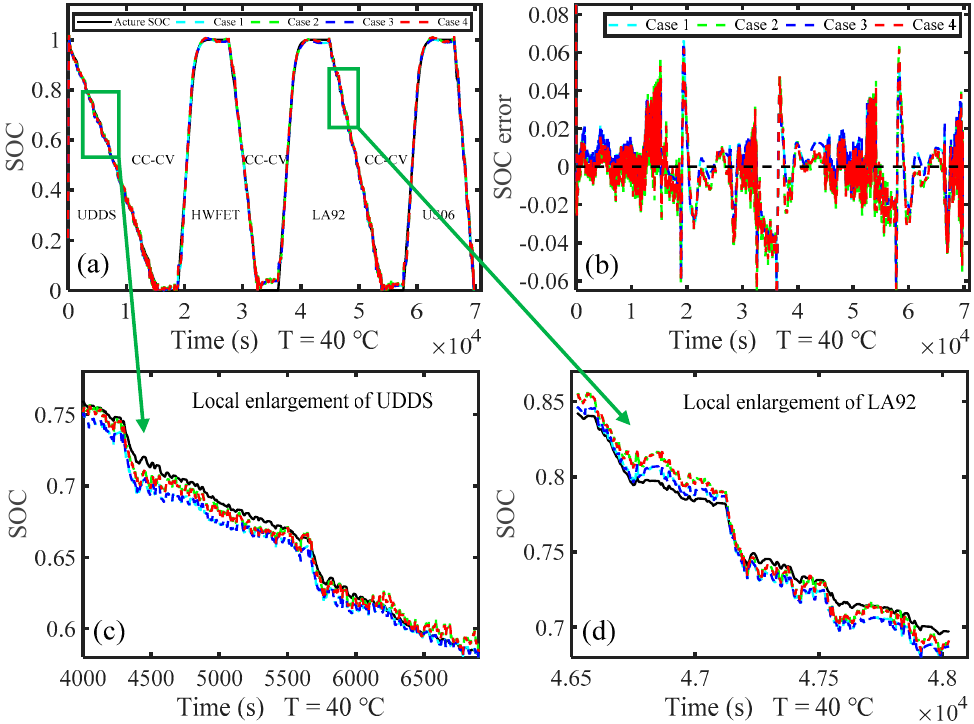
Figure 11. SOC and SOC error of GRU model in four cases at 40 °C: ( a ) SOC, ( b ) SOC error, ( c ) local enlargement of UDDS, ( d ) local enlargement of LA92.